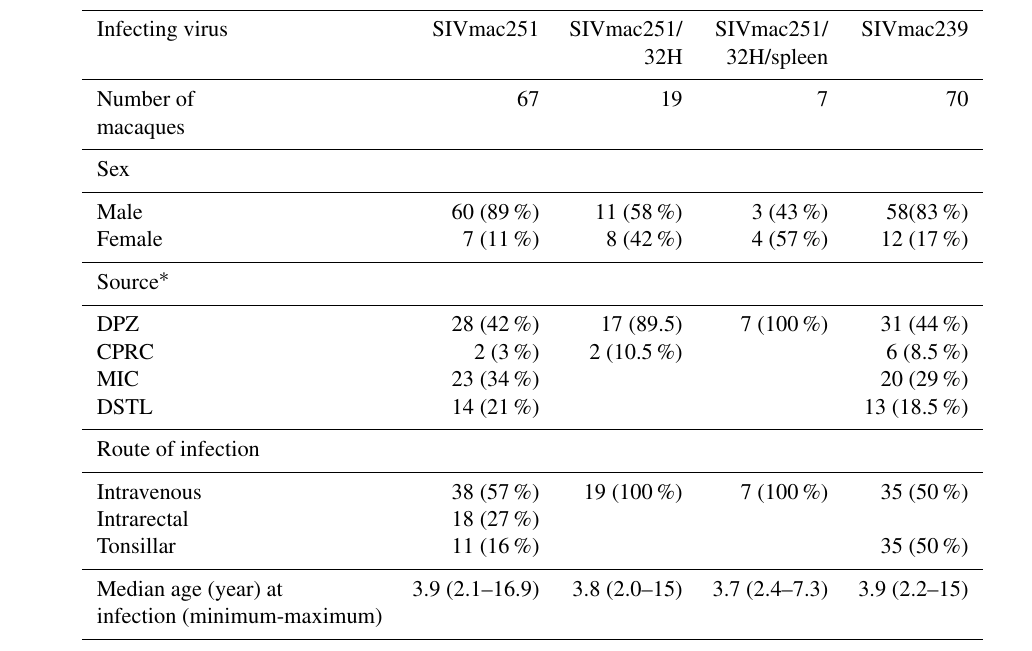
Table 1. Baseline characteristics of the SIV-infected rhesus macaques ( Macaca mulatta ) of Indian origin except for the two case reports.